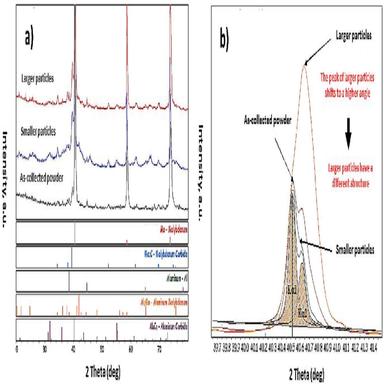
XRD patterns of a) the powders and b) the powders at a specific angle range.